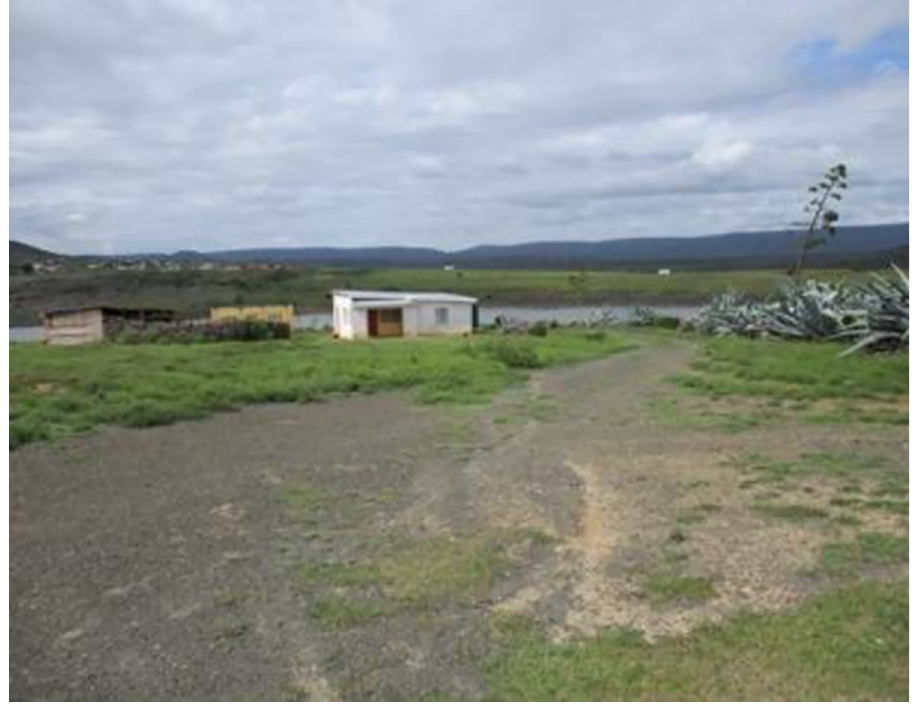
Fig 11. Image from co researcher 32–18.